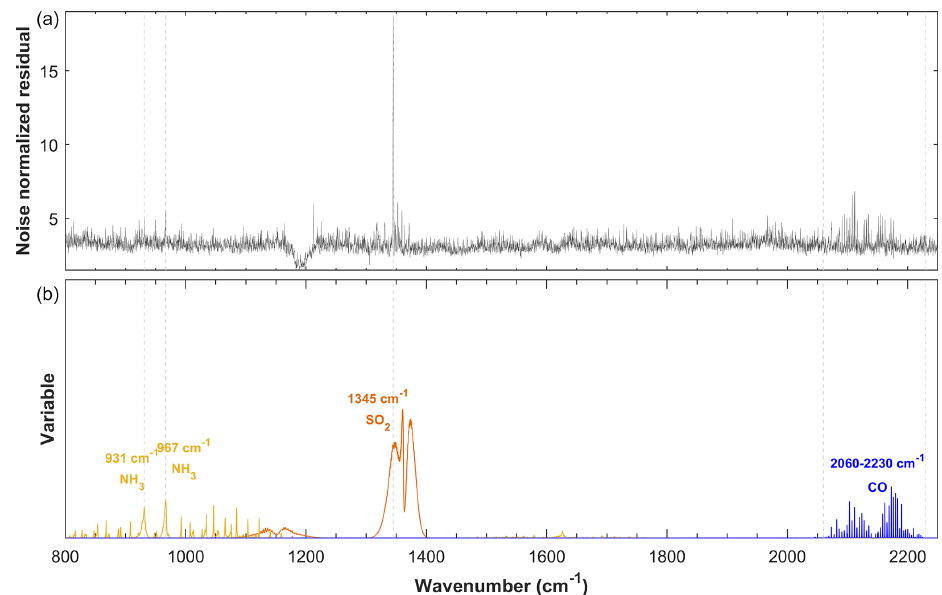
Figure 11. (a) Example of GMA pseudo-residual calculated from IASI/Metop-A L1C data during an anthropogenic pollution event occurring in China on 13 January 2013 in the evening (PM orbit). (b) The HITRAN spectroscopic parameters associated with the absorption of different species (Gordon et al., 2017, 2022) are shown with